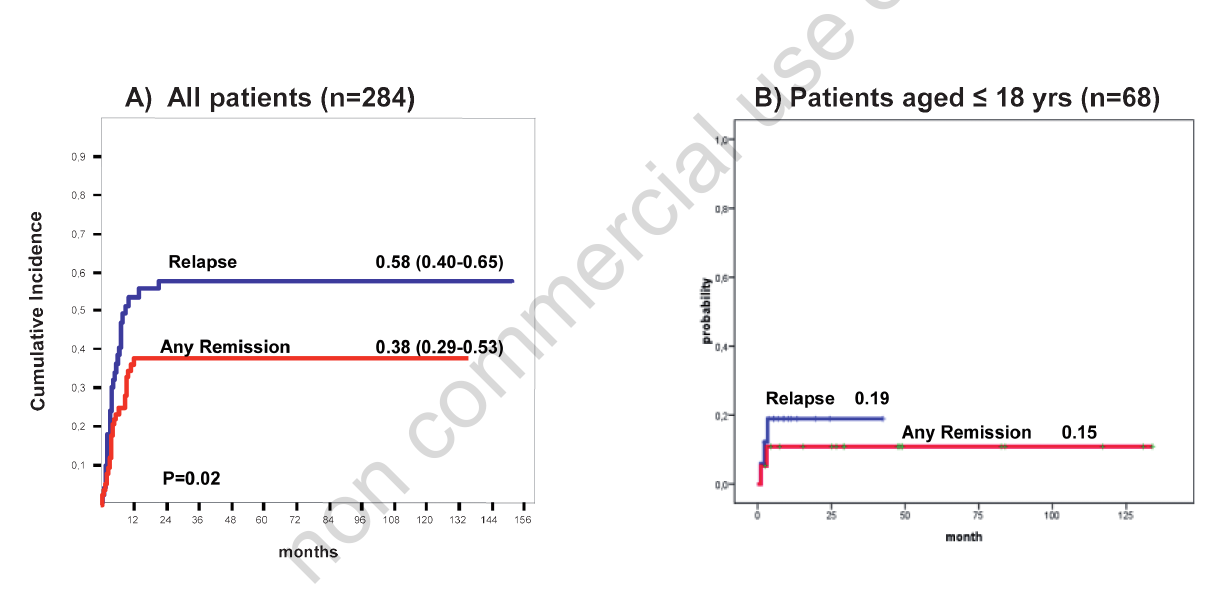
Figure 3. Non-relapse